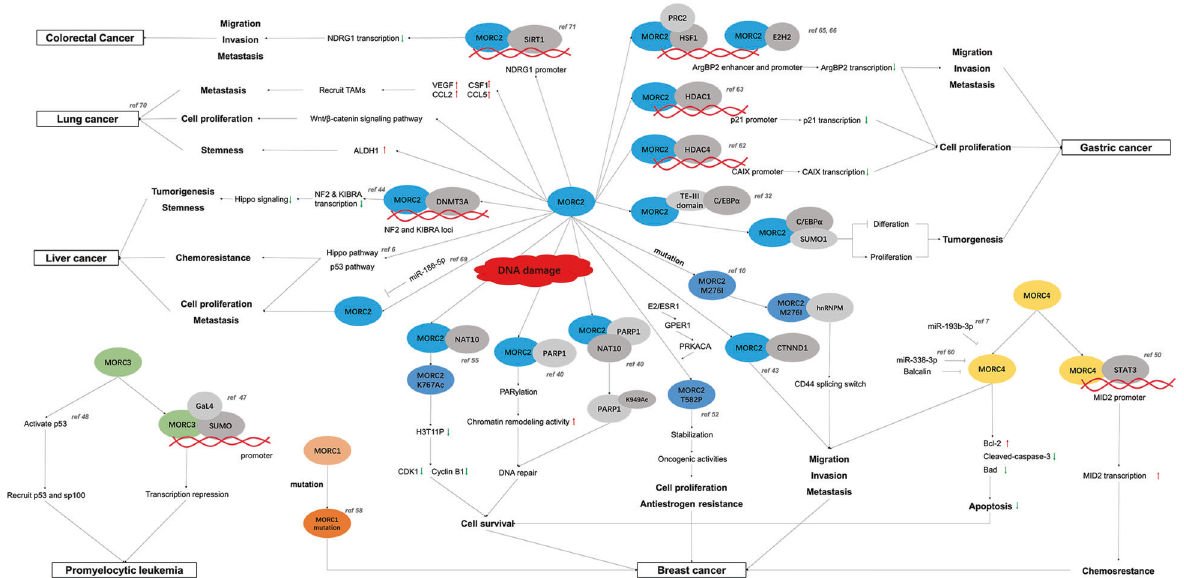
Fig. 4 The relationship of MORC family and cancers. In regulation of DNA damage response and gene transcription, MORC family regulate the expression of key proteins by interacting with their promoters (e.g. CAIX, NDRG1, NF2, KIBRA, and MID2) or their stability/activity by direct interaction (e.g. CTNND1, C/EBP α ) in pathways associated with cancer development, regulating cell proliferation, migration, invasion and metastasis of cancers, moreover affecting chemoresistance and stemness of cancers. Meanwhile, the stabilization/activity of MORC family are regulated by chromatin-associated enzymes (e.g. NAT10) and hormone (e.g. estrogen) in speci fi c cancer, such as MORC2 in breast cancer. Furthermore, the oncogenic mutation of MORC family involves the progression of breast cancer, such as MORC1 and MORC2